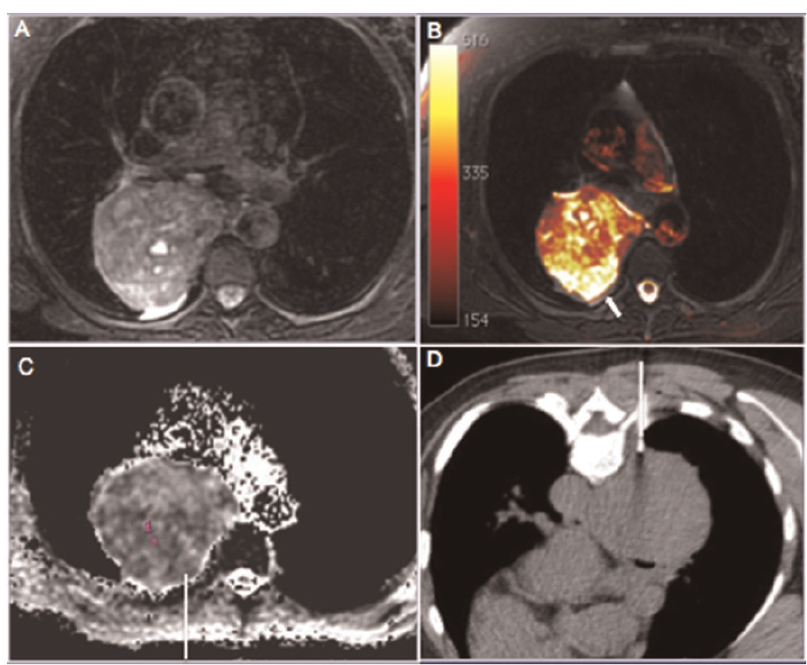
Figure 1 - A 62-year-old woman who presented with a heterogeneous mass in the right posterior mediastinum. The entire mass showed heterogeneous signal hyperintensity on T2-weighted magnetic resonance images ( a ) and fused T1- and diffusion-weighted images. ( b ) Note the remarkable signal hyperintensity in the posterior periphery of the lesion (arrow) compared with other areas, with definitive signs of restriction on the apparent diffusion coefficient (ADC) map. ( c ) The ADC value in the target area was 0.89 6 10 -3 mm 2 /s. The needle was directed to this area during computed tomography–guided biopsy. ( d ) Histopathological analysis yielded a diagnosis of pleomorphic leiomyosarcoma.